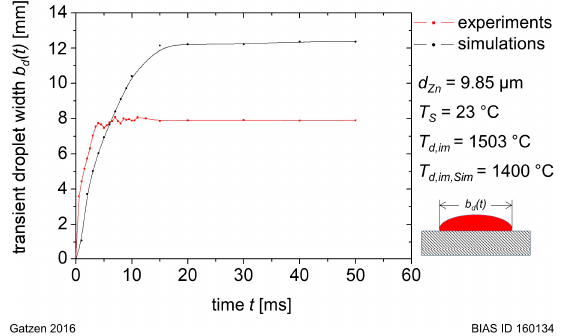
Figure 4. Comparison between measured and simulated transient droplet width.